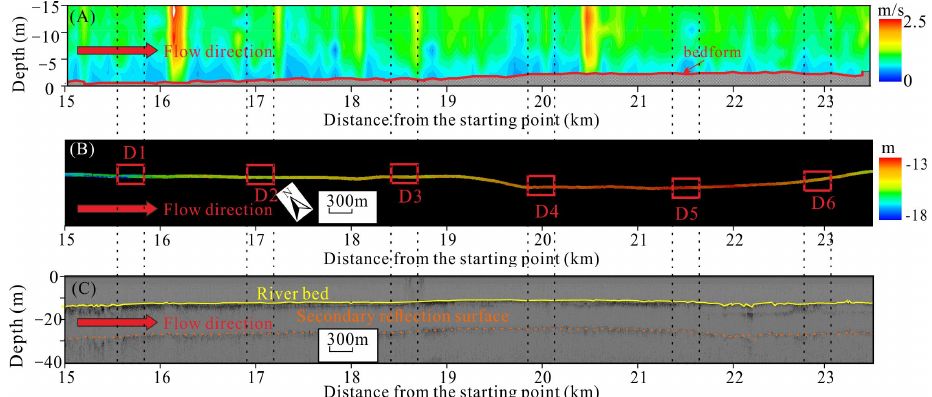
Figure 8. ( A ) Velocity profile along the SC (RK 15.5-RK 23.0). ( B ) MultiBeam echo sounder bathymetry. ( C ) Sub-bottom profile in the part of SC. Table 1. Characteristics of the riverbed dunes in the SC of the Yangtze River Estuary with inverse bed